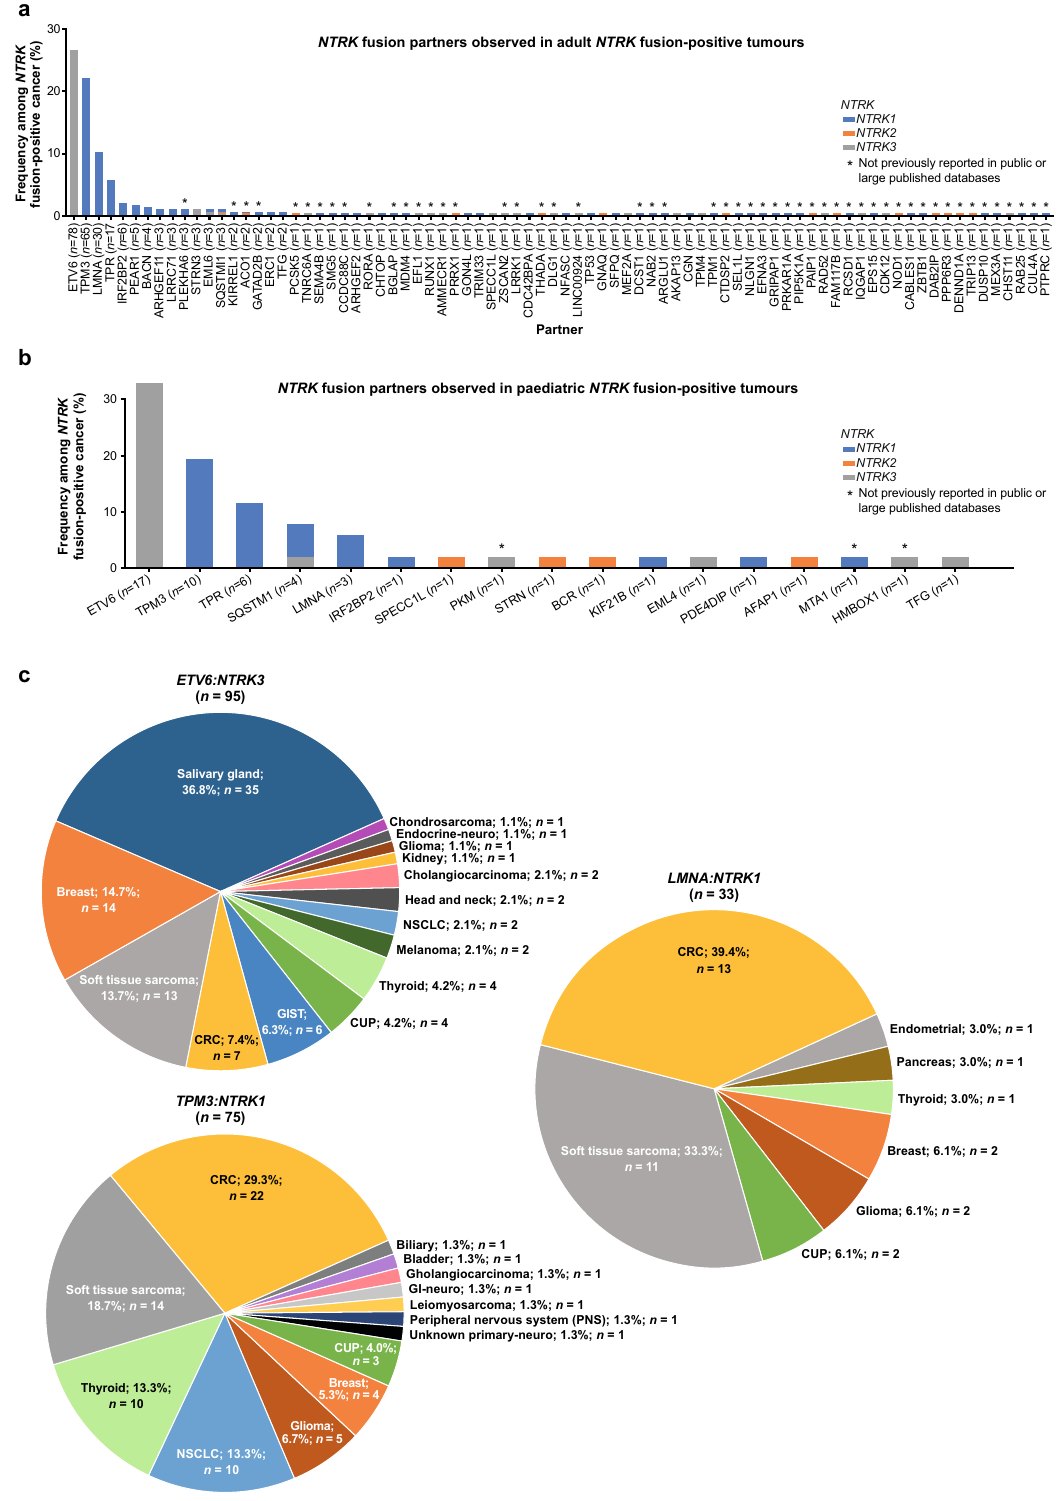
Fig. 2 The spectrum of NTRK fusion partners detected among NTRK fusion-positive solid tumours. Breakdown of NTRK gene fusions detected among adult ( a ) and paediatric patients ( b ) and the disease breakdown of the three most frequently observed NTRK fusion partners ( c ). CRC colorectal carcinoma, CUP unknown primary carcinoma, GI gastrointestinal, GIST gastrointestinal stromal tumour, NSCLC non-small cell lung cancer, NTRK neurotrophic tyrosine receptor